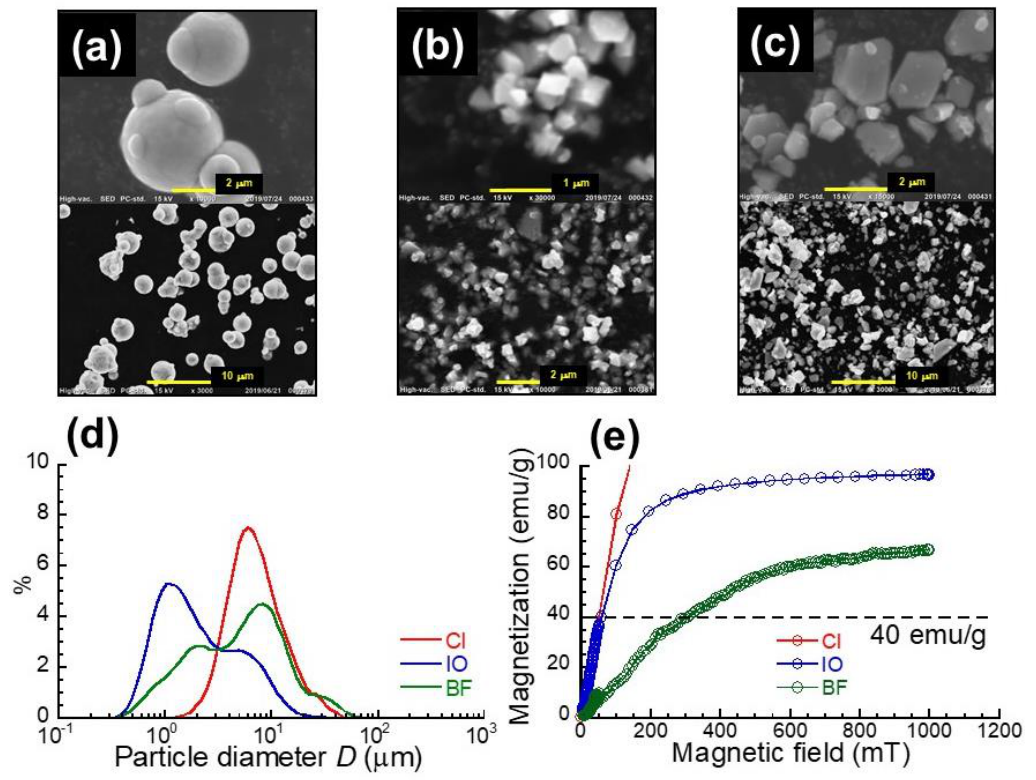
Figure 1. SEM photographs for ( a ) carbonyl iron, ( b ) iron oxide, and ( c ) barium ferrite particles. ( d ) Particle diameter distribution and ( e ) magnetization curves for these magnetic particles.